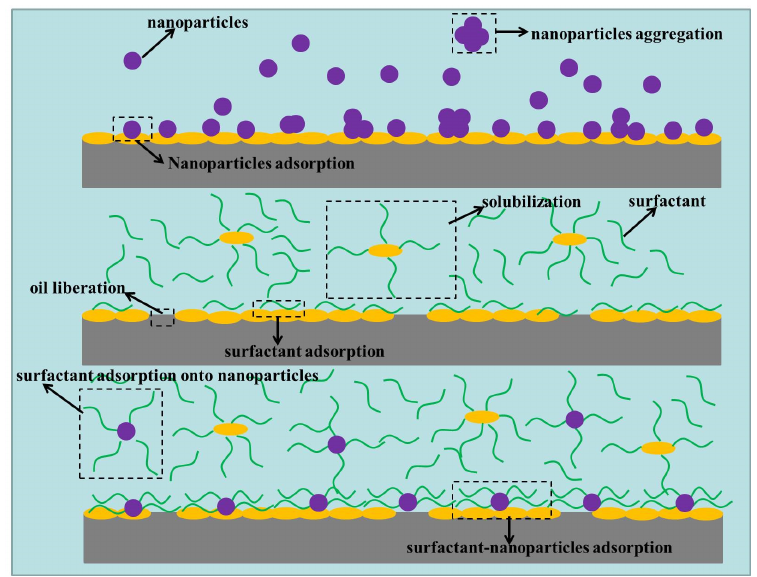
Figure 22. The mechanism of the synergistic effect of surfactants and nanofluids on oil-wet calcite surface wettability alteration. surface wettability